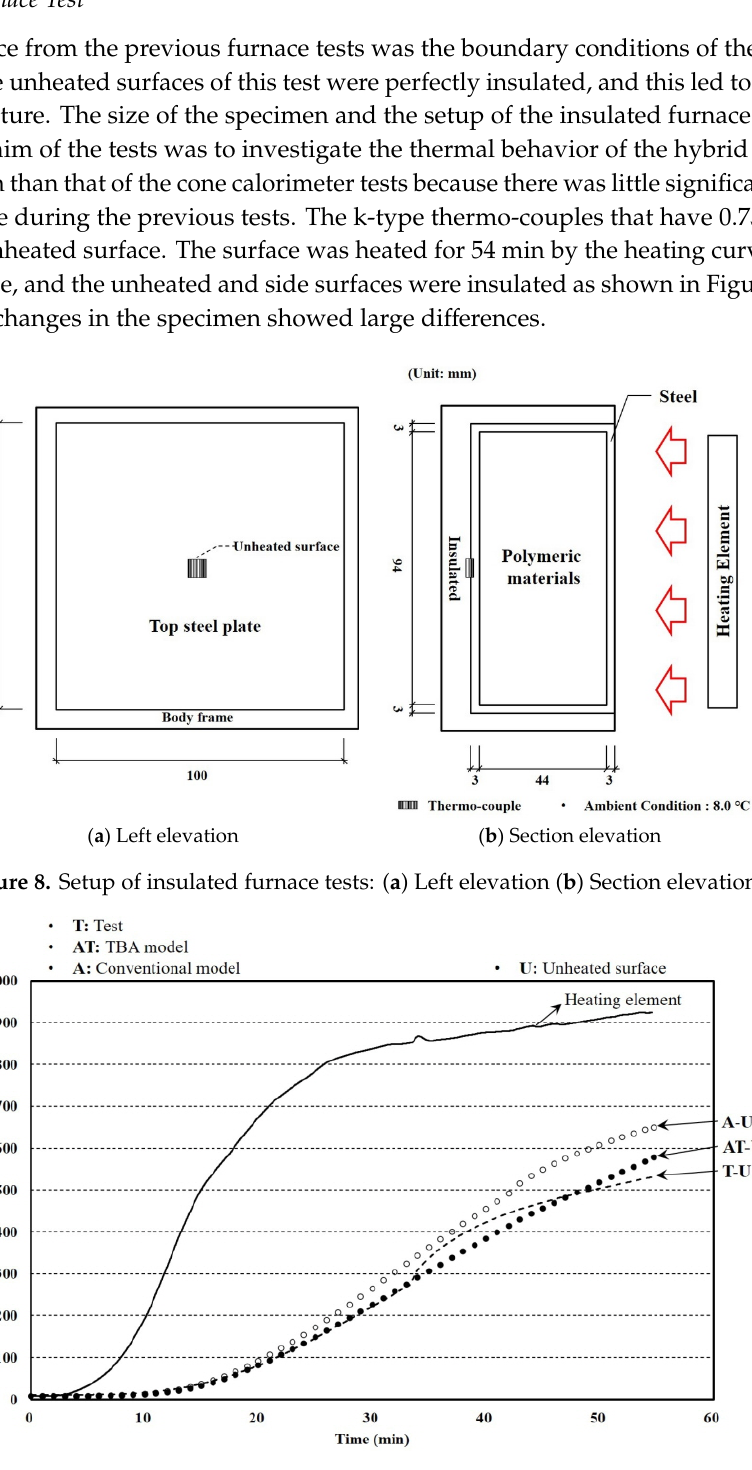
Figure 7. Temperature results of furnace tests and finite element analysis (FEA).